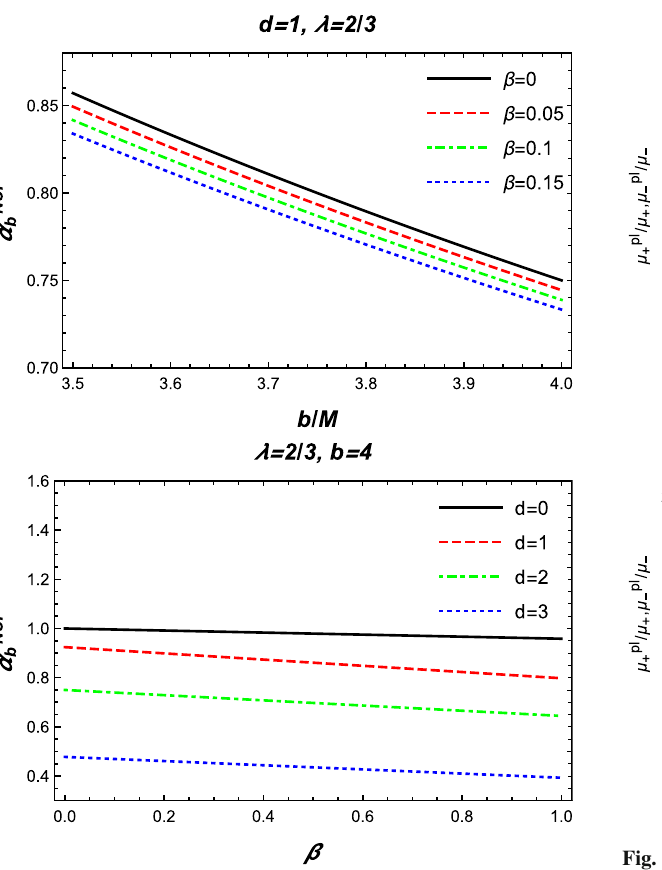
Fig. 19 α b for different value b , d and β in the non uniform plasma, λ = 2 / 3 case